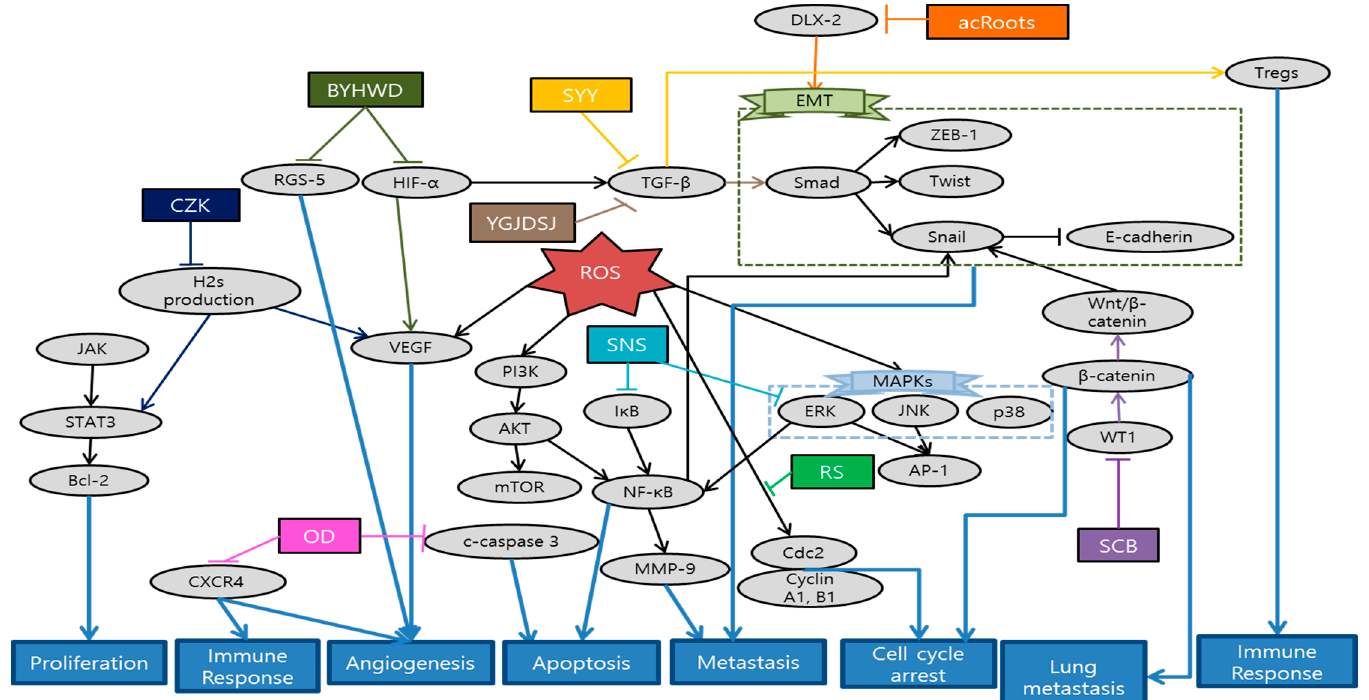
Figure 4. Schematic diagram of anti-metastatic mechanisms of herbal medicine in liver cancer: Herbal medicines interrupt signaling transduction and EMT cascades related with cancer cell migration and metastasis. ERK/JNK signaling pathway activates the AP-1 activity. Precedent cascades of ERK/PI3K/AKT regulate the NF- κ B activity. Both AP-1 and NF- κ B bind to promoter sites of MMP-9. distal-less homeobox 2 (DLX2) can activate the EMT process which generally begins with TGF- β 1 by Smad3 phosphorylation. Wnt/ β -catenin pathway and its transcription activity also activate Snail, composing a process of EMT. On the other hand, immuno-elevating and anti-angiogenic effects of herbal medicines can inhibit microenvironment creation for cancer metastasis. VEGF, RGS-5, and HIF-1 α create some of the tumor microenvironments and vasculature. Cancer cells can induce an immuno-suppressive microenvironment that makes tumor growth and metastasis available by secreting TGF- β 1 and recruiting Tregs or differentiating CD4. Abbrevation: acRoots, Actinidia chinensis Planch root; OD, Oldenlandia diffusa ; RS, Rhazya stricta ; SCB, Salvia chinensis Benth; BYHWD, Buyang Huanwu decoction; CZK, combination of curcuma zedoary and kelp; SNS, Sini-san; SYY, SongYouYin; YGJDSJ, Yanggan Jiedu Sanjie.